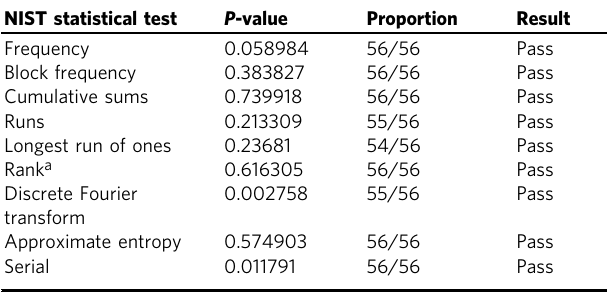
Fig. 4 Von Neumann de-biasing. Morphology of pools containing bit streams before and after processing using Von Neumann algorithm (data from synthesis 1 by Microsynth, nucleotide-to-bit mapping A → 0, C → 0, T → 1, G → 1). The cumulative sum across each bit stream in both bit pools was computed by assigning each 0 to the value of − 1 and each 1 to the value of 1. The distribution of raw bit streams (dark blue) is not centered around zero, whereas the distribution of raw de-biased bit streams (turquoise) is centered around zero. The expected Gaussian distribution is marked in red. Source data are provided in the Source Data fi le. Table 1 NIST statistical test suite randomness